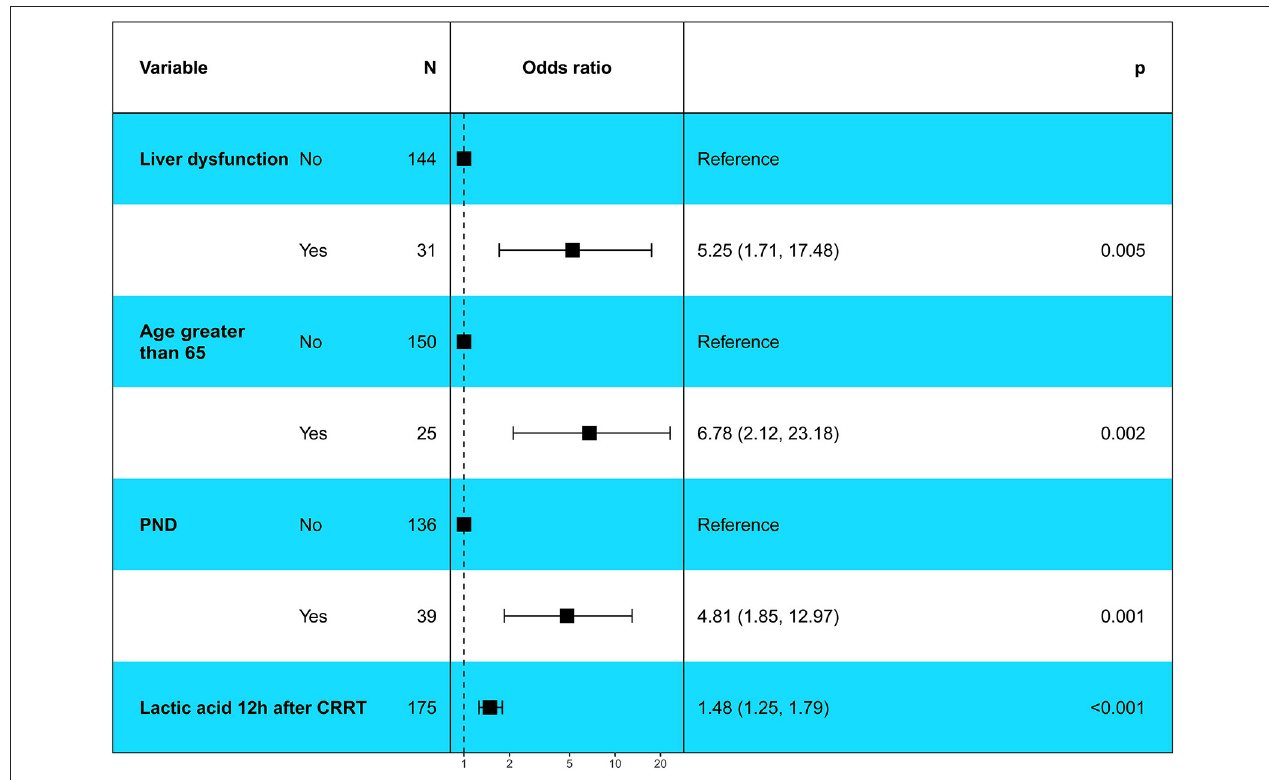
FIGURE 2 | Multivariable logistic regression analysis showed the independent risk factors of in-hospital death in patients with postoperative AKI undergoing CRRT after ATAAD surgery. PND, Permanent neurological